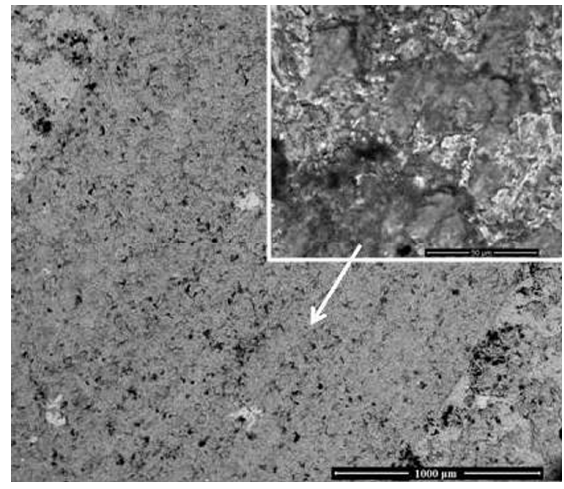
Figure 7. Morphology of the wear track of the zircon-based ceramics coating (SEM, back-scattered electron mode). Coatings 2017 , 7 , 142